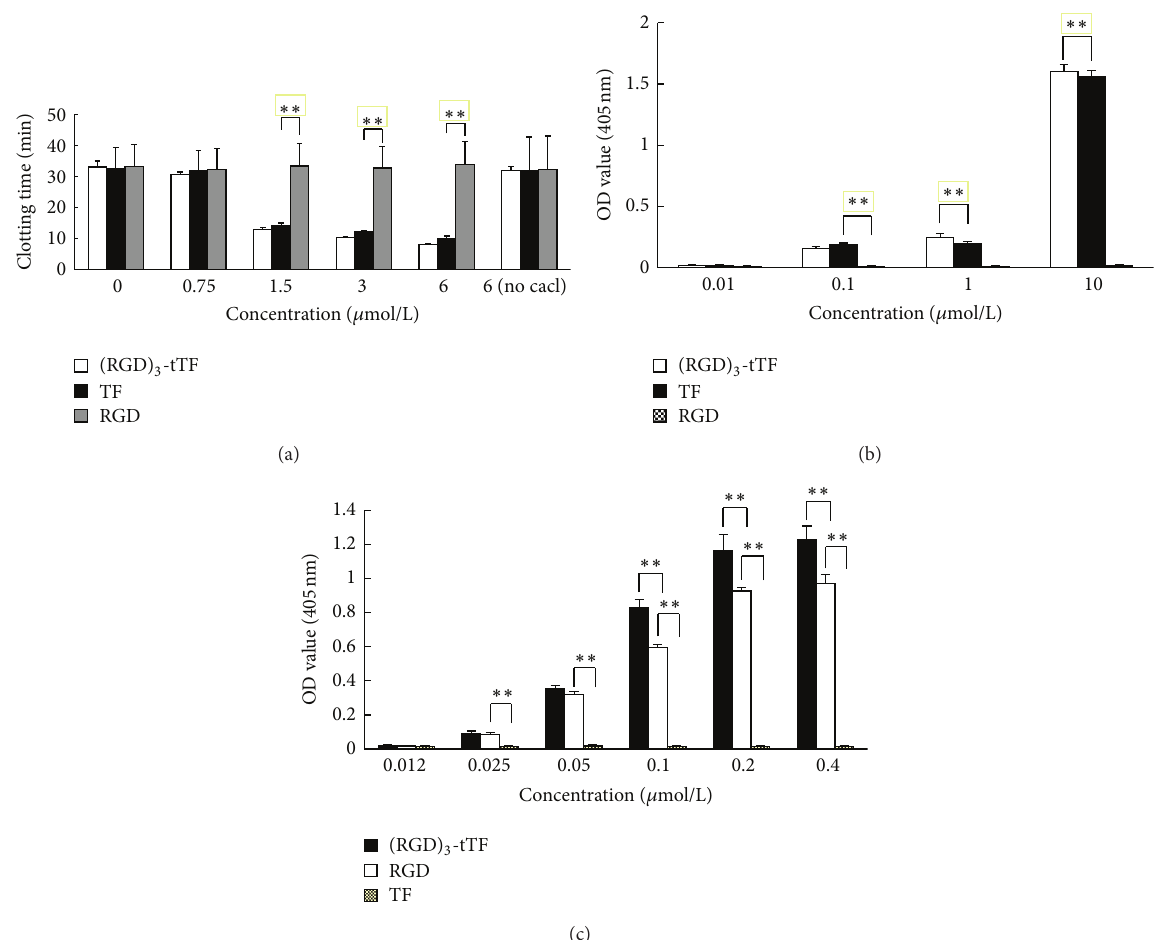
Figure 2: Bioactivity of (RGD) 3 -tTF. (a) Clotting time. The clotting time of (RGD) 3 -tTF was similar to that of TF but significantly higher than that of RGD; there was no significant difference between (RGD) 3 -tTF and TF ( ∗ 𝑃 < 0.05 , ∗∗ 𝑃 < 0.01) . (b) Factor X (FX) activation. At 1 𝜇 mol/L or higher concentration, the activation FX by (RGD) 3 -tTF is comparable to that of free TF but significantly higher than that of RGD ( ∗ 𝑃 < 0.05 , ∗∗ 𝑃 < 0.01 ). (c) Specific binding to 𝛼 V 𝛽 3 . (RGD) 3 -tTF binding with 𝛼 V 𝛽 3 was significantly higher than that of RGD and TF ( 𝑃 < 0.01 ), and RGD binding with 𝛼 V 𝛽 3 was significantly stronger than that of TF ( ∗ 𝑃 < 0.05 , ∗∗ 𝑃 < 0.01 ).